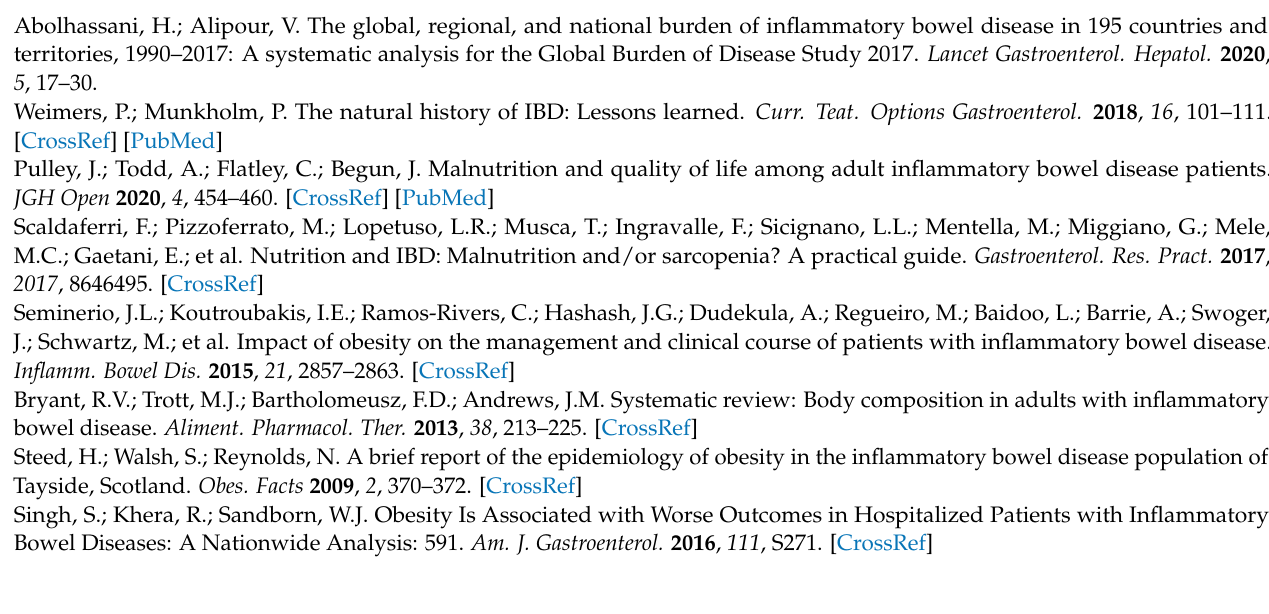
son. Figure S1. Funnel plots to assess publication bias ((a) Inflammatory bowel disease in obese individuals, (b) Inflammatory bowel disease in underweight individuals, (c) Crohn’s disease in un- derweight individuals, (d) Crohn’s disease in obese individuals, (e) Ulcerative colitis in underweights individuals, and (f) Ulcerative colitis in obese